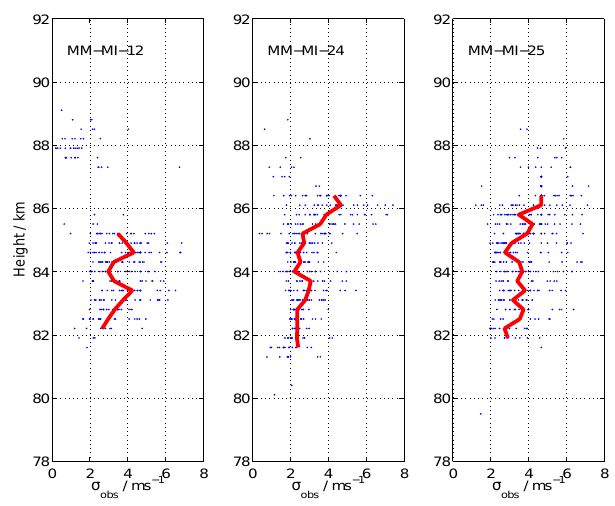
Fig. 5. Anisotropy ratio calculated from the mean aspect sensitivity shown in Fig. 4 for the three MIDAS rocket flights. The white area defines the values where the SNR is larger than 0dB. These param- eters describe the degree of anisotropy of the scattering eddies.